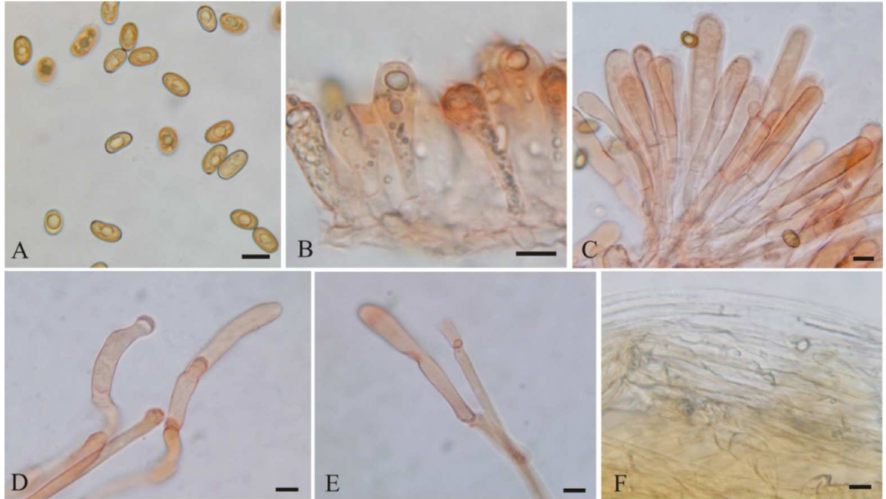
Figure 6. Pseudosperma gilvum (BJTC FM1941) ( A ) Basidiospores, ( B ) Basidia, ( C ) Cheilocystidia, ( D , E ). Caulocystidia, ( F ) Pileipellis. Scale bars: ( A – F ) = 10 µ m. MycoBank: